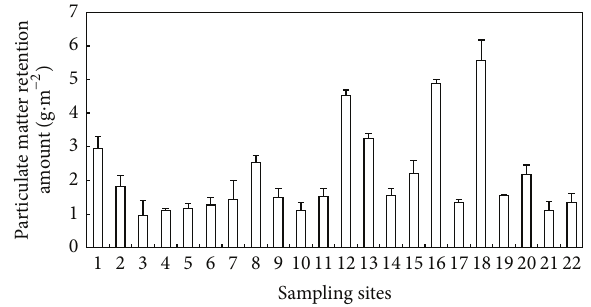
Figure 3: The amount (g ⋅ m −2 ) of PM deposited on leaves of L . lucidum grown at 22 sampling sites differing in pollution level (data are mean ± SD).